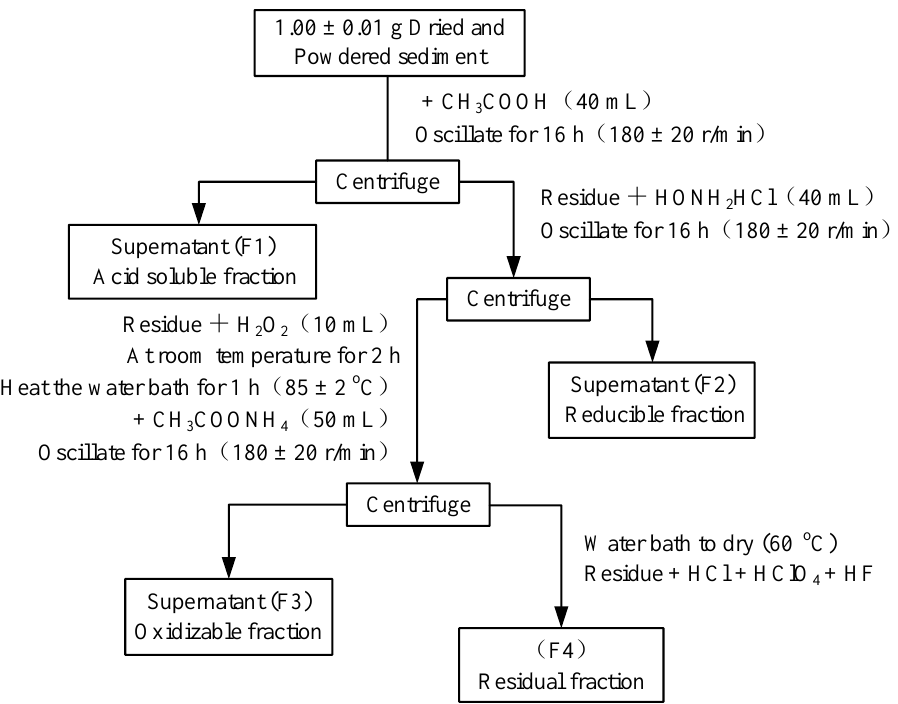
Figure 2. Sequential extraction process based on the European Community Bureau of Reference method.